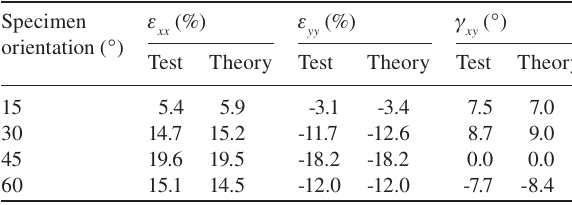
Table 3 Comparison of failure strain